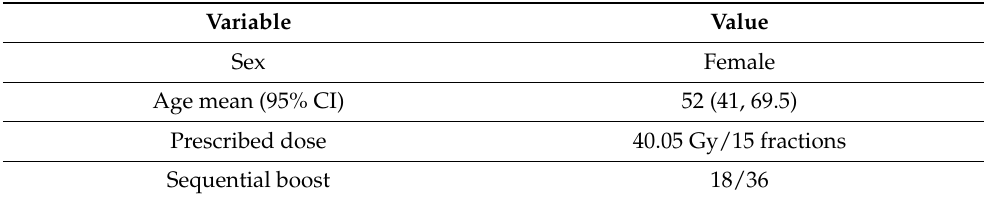
Table 1. Treatment and patient data of the cohort in the